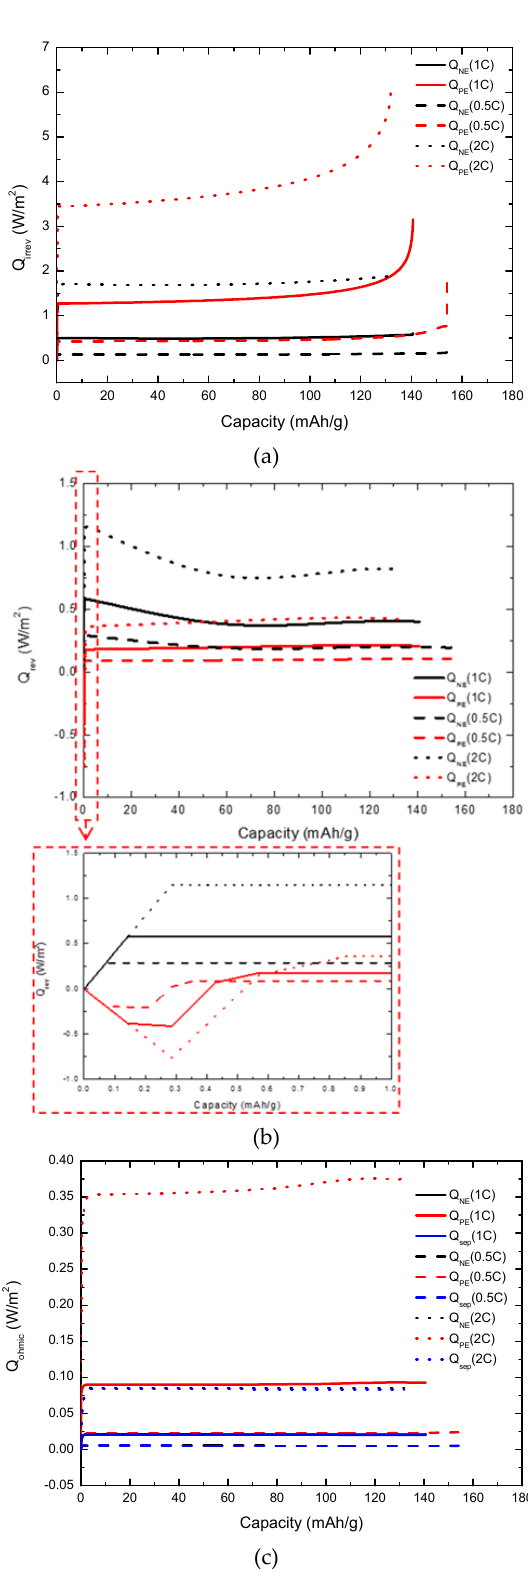
Figure 9. Individual heat generation terms as a function of the cell capacity during charging: ( a ) irreversible reaction heat, ( b ) entropic heat, and ( c ) ohmic joule heating.